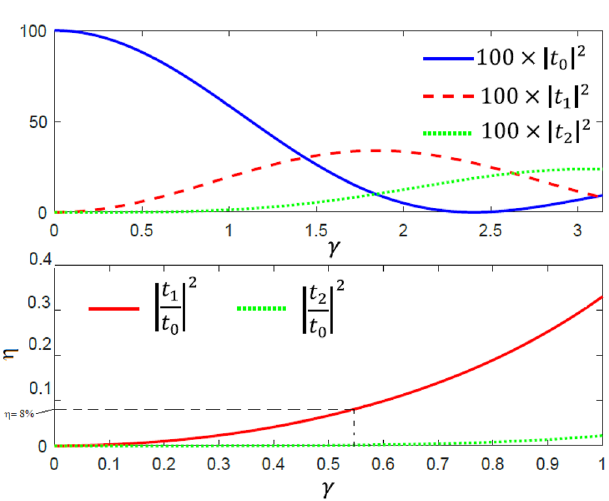
Figure 14. The transmittance and diffracted efficiency diagrams obtained by simulation results for the LC cell with the cell thickness t = 20 micron and incident wavelength (cid:31) 0